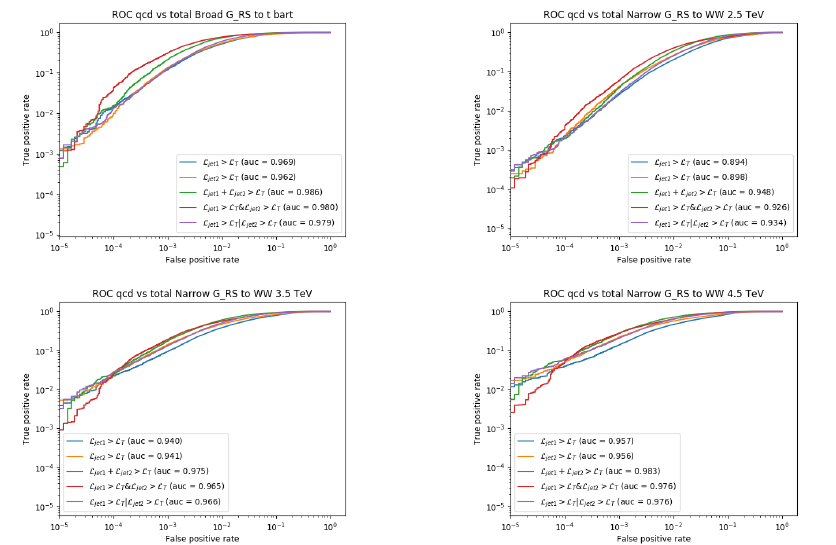
Figure 5. ROC curves for G RS → t ¯ t (top left), G RS → WW 2 . 5 TeV (top right), G RS → WW 3 . 5 TeV (bottom left) and G RS → WW 4 . 5 TeV (bottom right) with di ff erent loss combination strategies (distinct lines in each